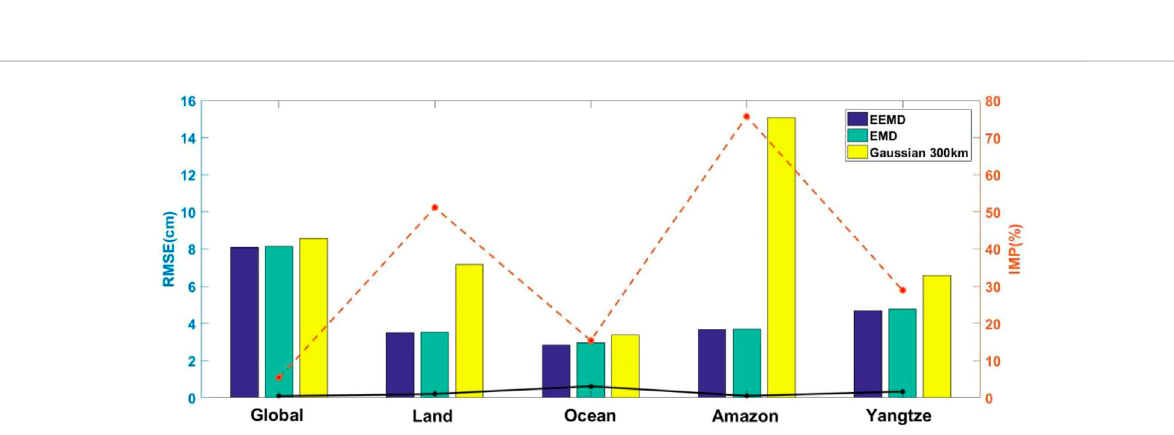
Frontiers in Earth